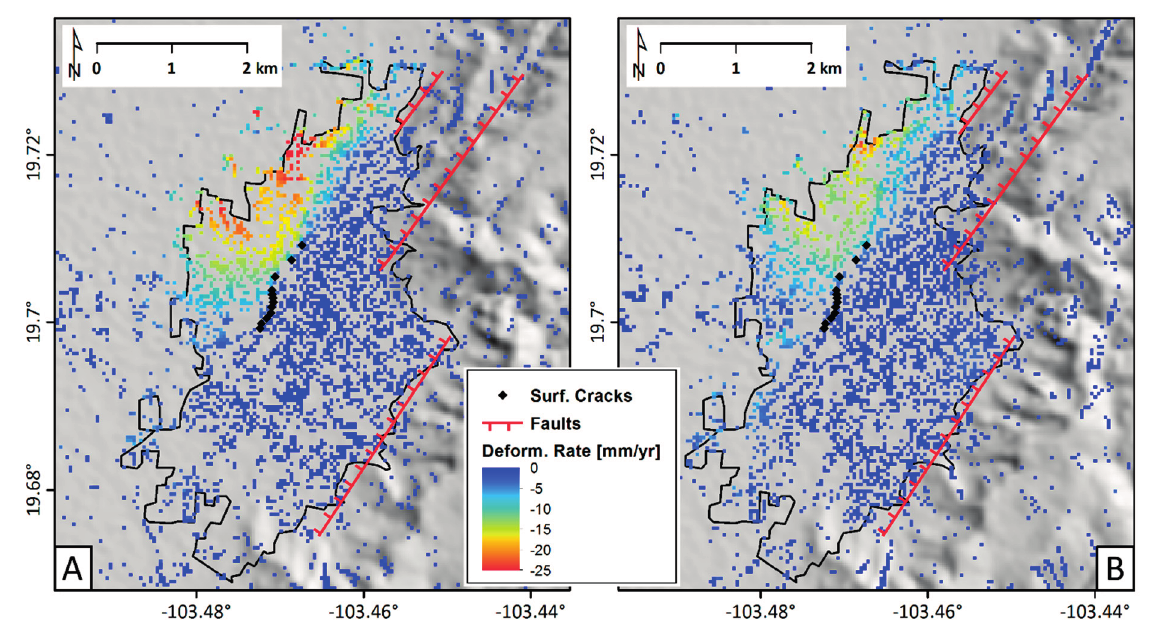
Figure 5. Surface deformation velocities (deformation rate) estimated by the Multi-Baseline method, applied to ( a ) ascending and ( b ) descending ENVISAT data. Known faults and the cracks observed on the field are superimposed.